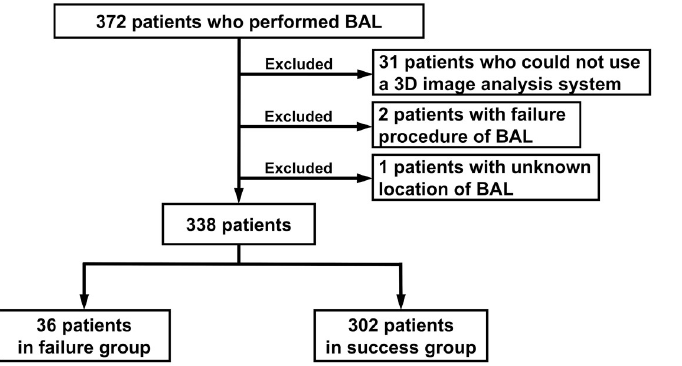
Fig 1. Flowchart of the study. BAL bronchoalveolar lavage fluid.